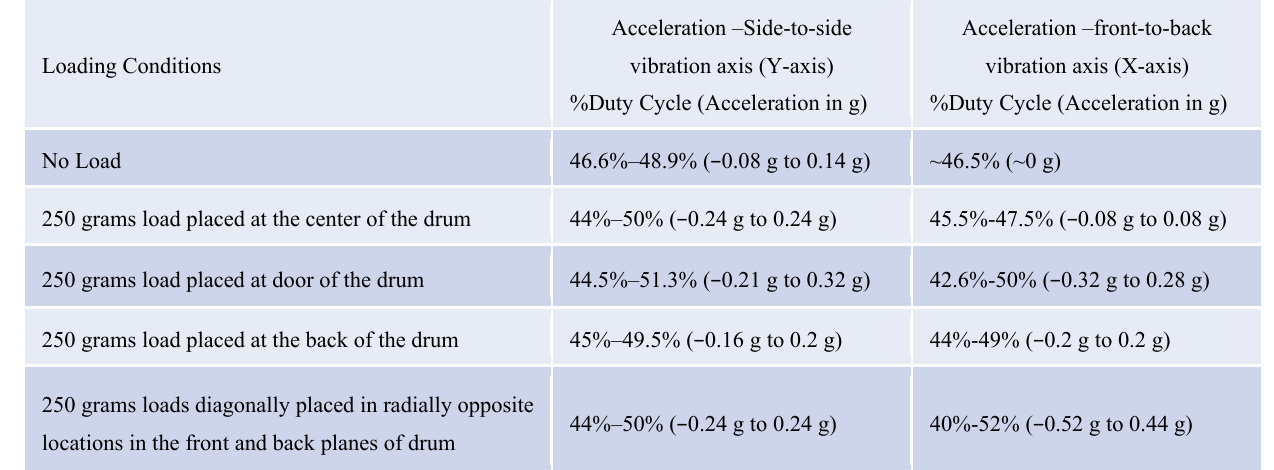
Table 1. Unbalance detection tests carried out at 400